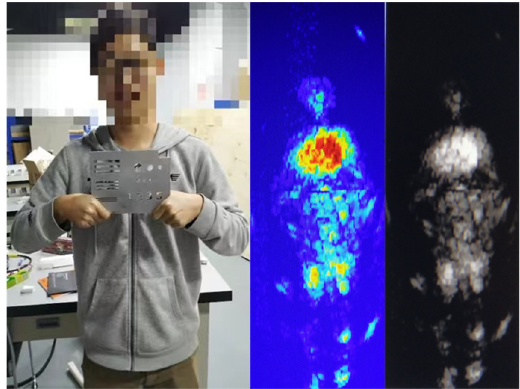
Figure 22. Schematic diagram of the 220 GHz remote sensing imager.